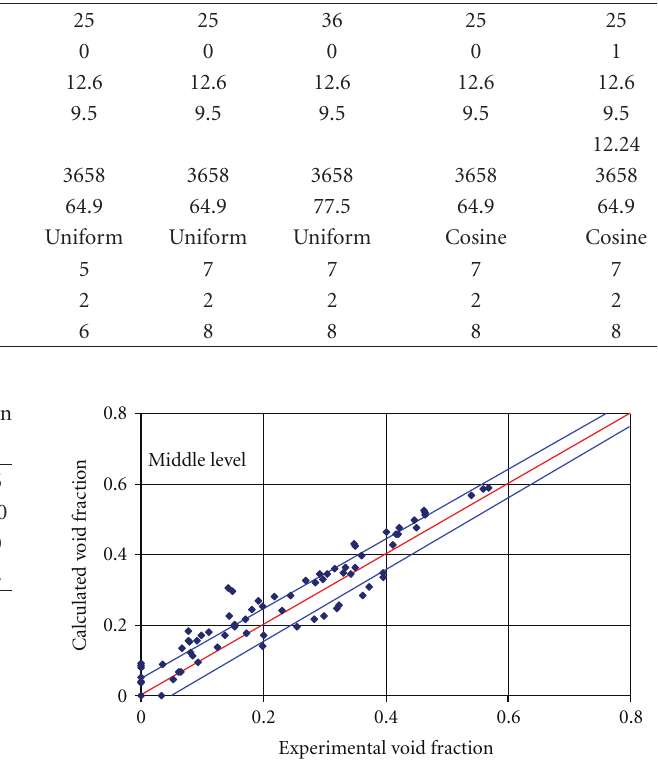
Figure 7: Comparison of calculated and measured void fraction for case B5 at the middle axial level.